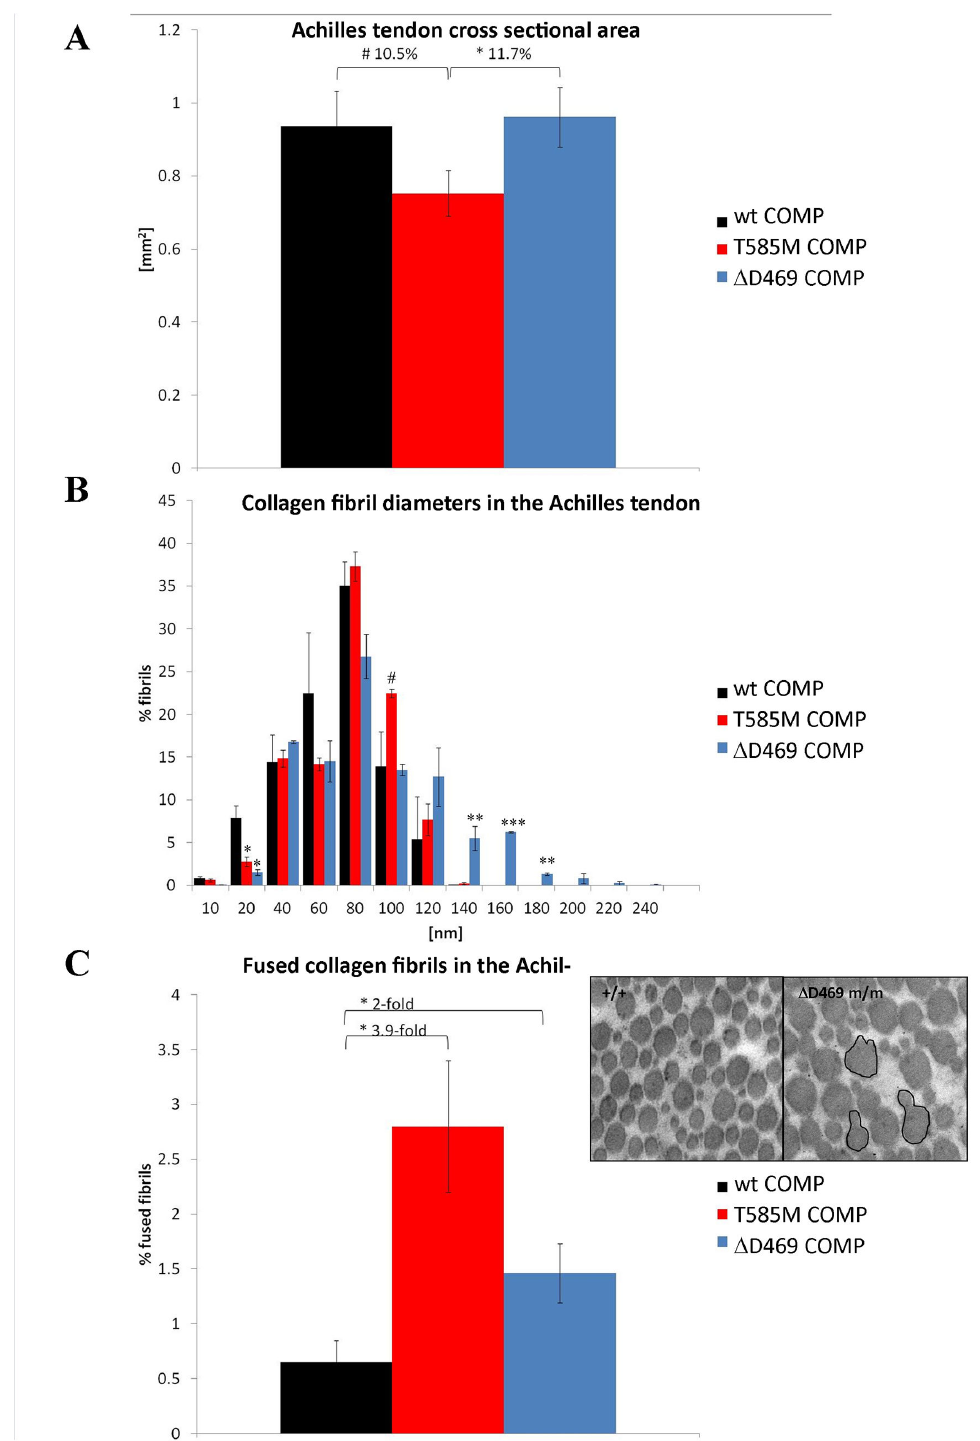
Figure 4. Analysis of ultrastructure of the mutant COMP Achilles tendon at 3 weeks. A ) Measurement of the cross sectional area of wild type and mutant tendons. T585M COMP tendons but not ΔD469 COMP mutant tendons were thinner than wild type controls at 3 weeks, n>10. B ) Both COMP mutant tendons contained more of the thicker collagen fibers than the wild type controls, n=3. C ) Both COMP mutant tendons contained more fused/branching collagen fibers when compared to the wild type tissues at 3 weeks of age, n=3. Error bars; SEM (standard error of the mean). Key: * P<0.05, ** P<0.01, *** P<0.001 (t-test). doi: 10.1371/journal.pone.0082412.g004 PLOS ONE |